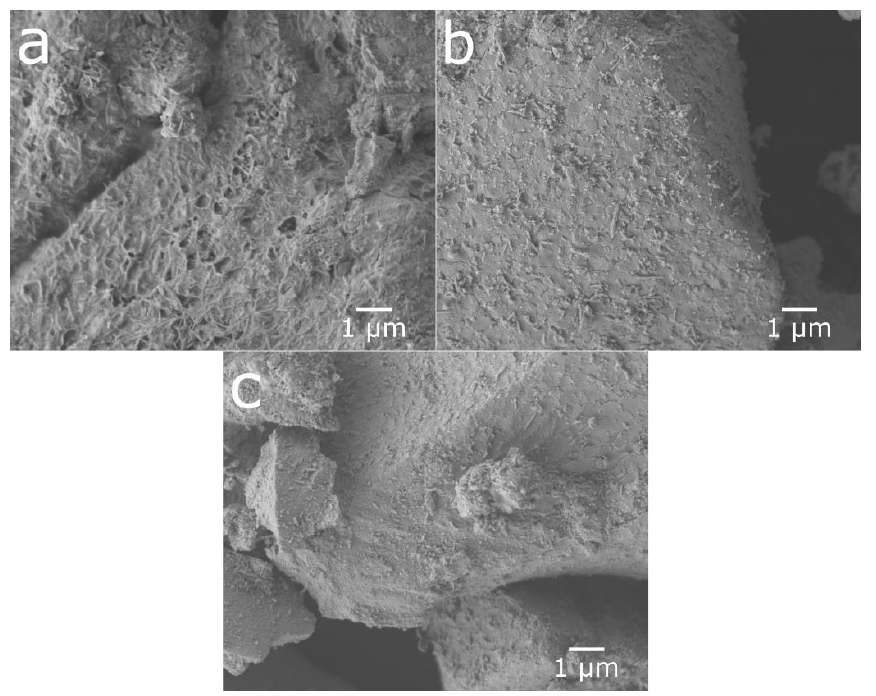
Figure 4. SEM micrographs of particle surfaces from ( a ) cycled material, ( b ) material from the ultrasonic bath, and ( c ) ball-milled material.